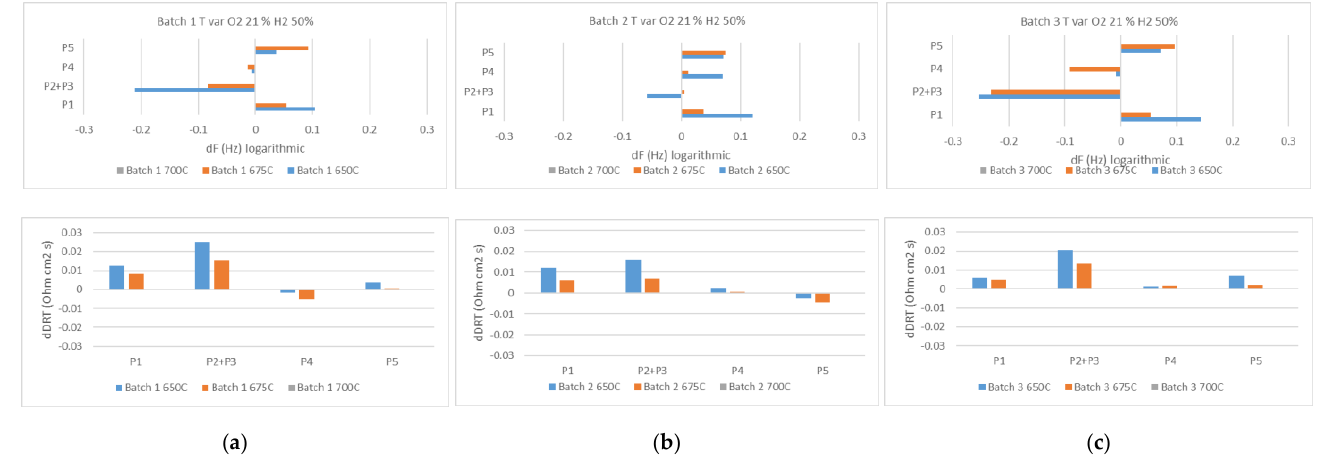
Figure 12. Frequency and DRT change due to temperature variation at H 2 50% and O 2 21%. ( a ) Batch 1; ( b ) Batch 2; ( c ) Batch 3.